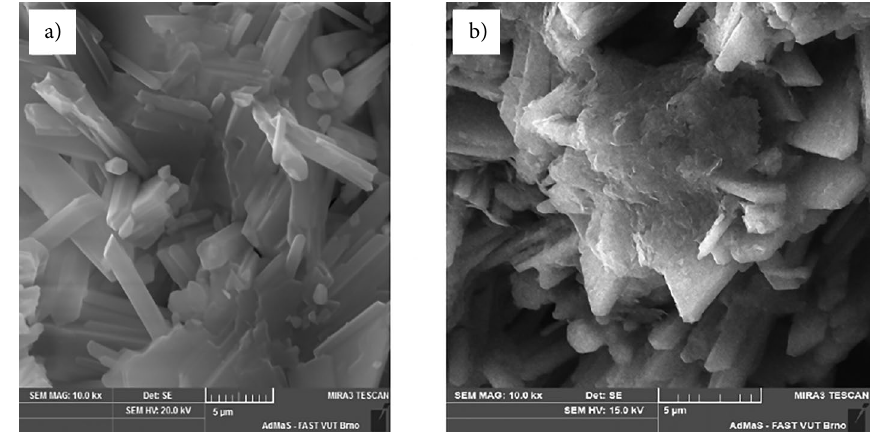
Figure 4. Microstructure study: the check sample (a), the sample with 7.5% of modified technical sulfur (b)